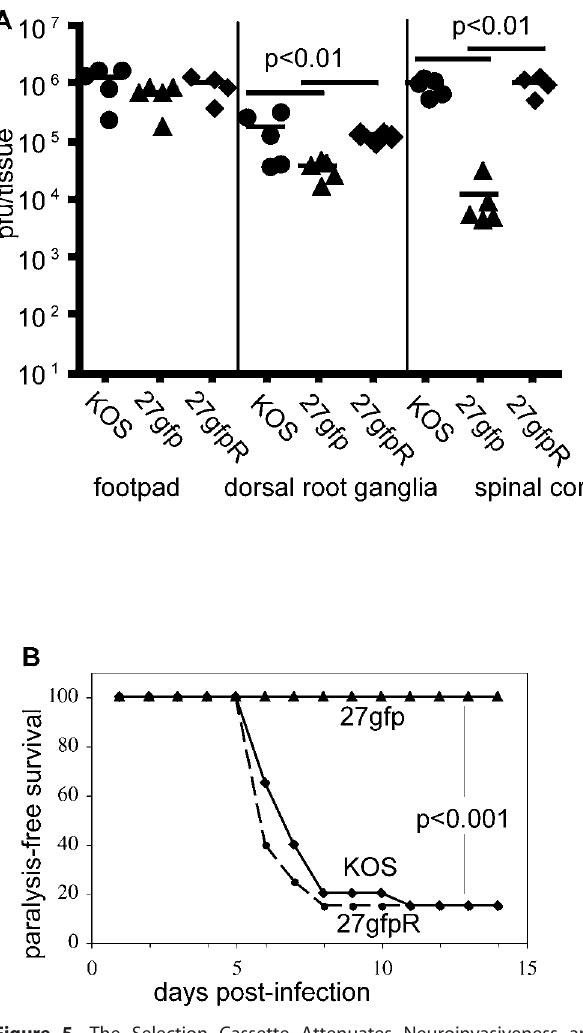
Figure 5. The Selection Cassette Attenuates Neuroinvasiveness and Neurovirulence BALB/c mice were infected in the hind footpads with 2.5 3 10 5 pfu of KOS, 27gfp, or 27gfpR. (A) The indicated tissues were isolated on day 6, homogenized, and viral titers were determined on vero cells. (B) Ten (27gfp) or 20 (KOS and 27gfpR) mice per virus were monitored for paralysis induction for 14 d. Mice displaying ataxia or paralysis were euthanized. DOI: 10.1371/journal.ppat.0010007.g005